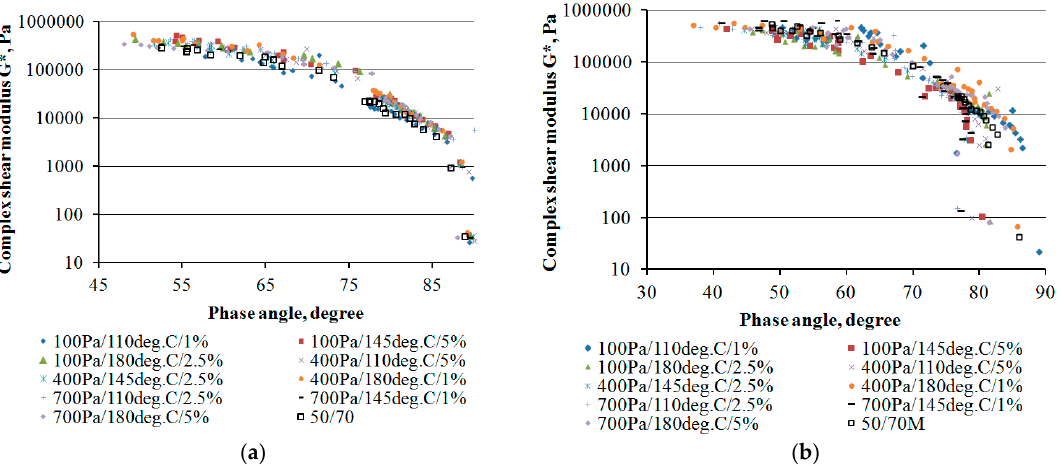
Figure 5. Black curve based on the data determined at 40 °C and 60 °C: ( a ) bitumen 50/70; and ( b ) bitumen 50/70 M.